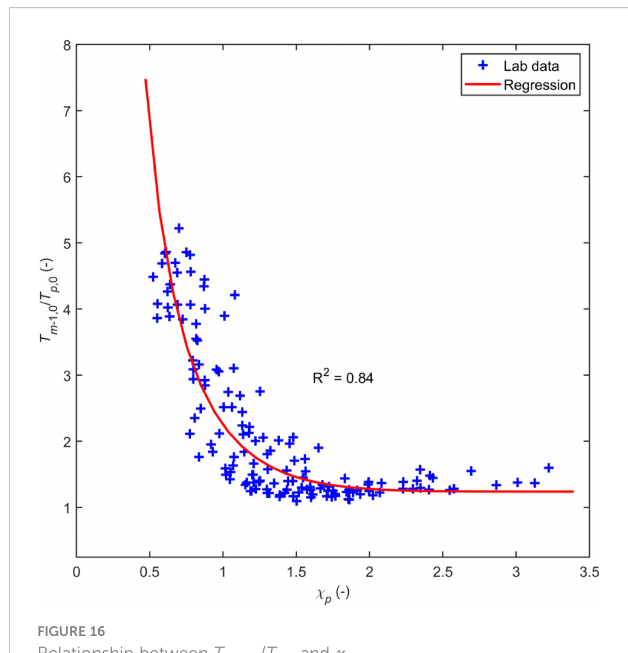
FIGURE 16 Relationship between T m -1,0 / T p ,0 and c p